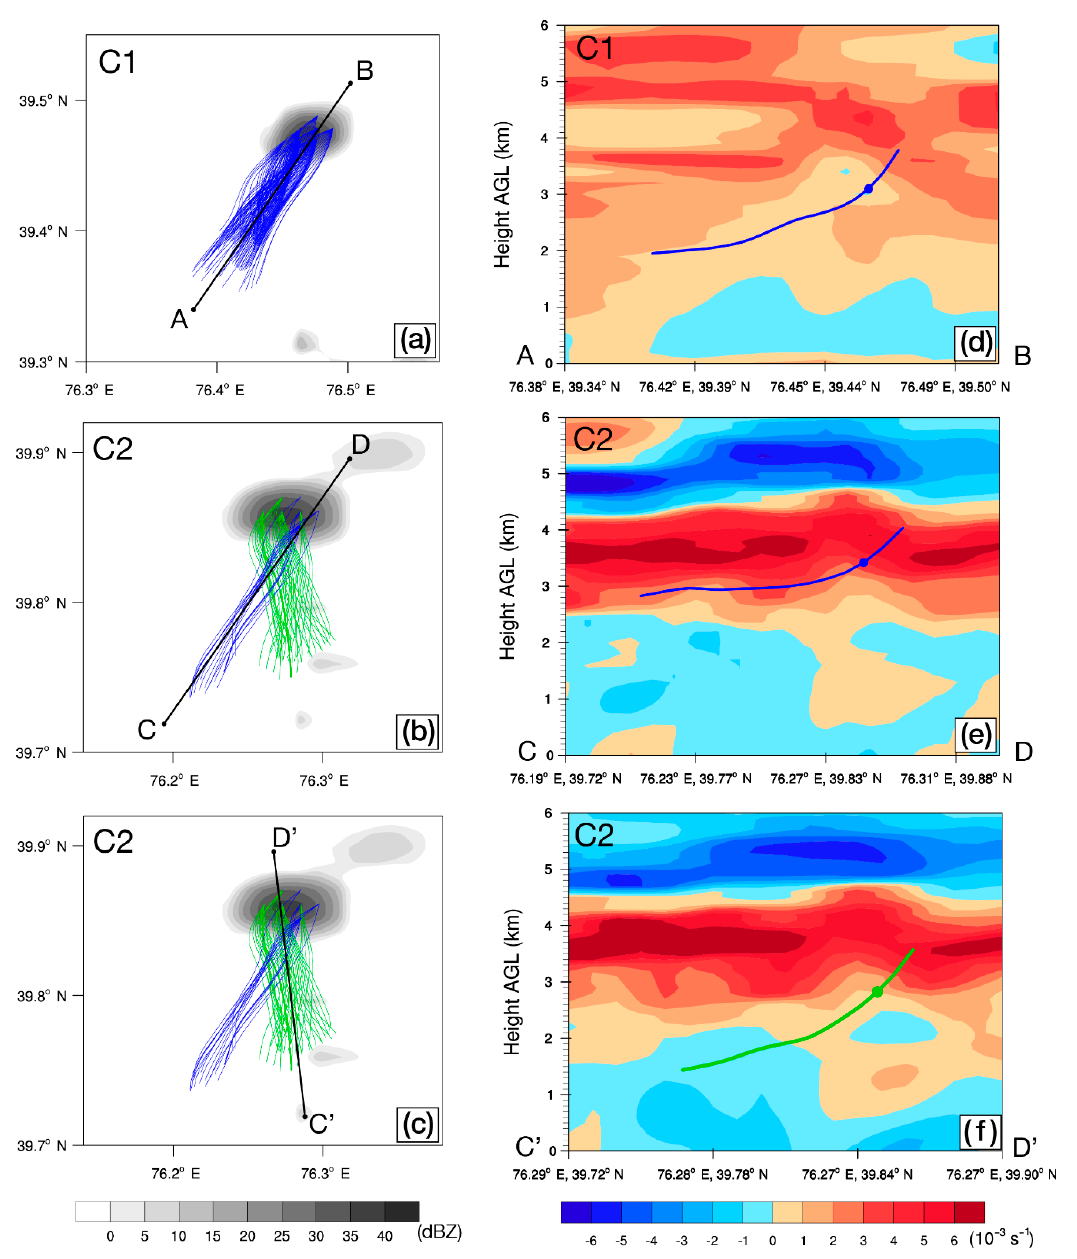
Figure 12. ( a ) Simulated composite reflectivity (shading; unit: dBZ) and ground-relative backward trajectories (blue lines, projected to the ground) of air parcels for 1 h within the C1 released at 1133 UTC. ( b , c ) are the same as ( a ) but for the ground-relative backward trajectories from southwest (south) are colored in blue (green) within the C2 released at 1142 UTC. ( d ) Vertical cross sections of vertical shear of the horizontal wind (shading, unit: 10 − 3 · s − 1 ) and averaged height of the backward trajectories (bold blue line) and air parcels at 1127 UTC (bold blue dot) (projected to the vertical cross section) along the line segment AB. ( e , f ) are the same as ( d ) but for the average height of the backward trajectories and air parcels at 1136 UTC that came from the southwest (south) are colored in blue (green) along the line segments CD and C’D’,